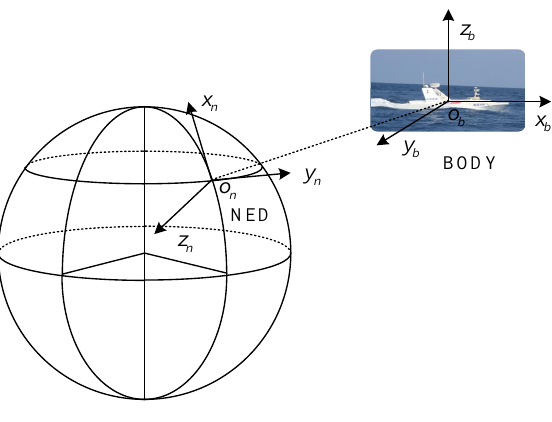
Figure A1. Coordinate